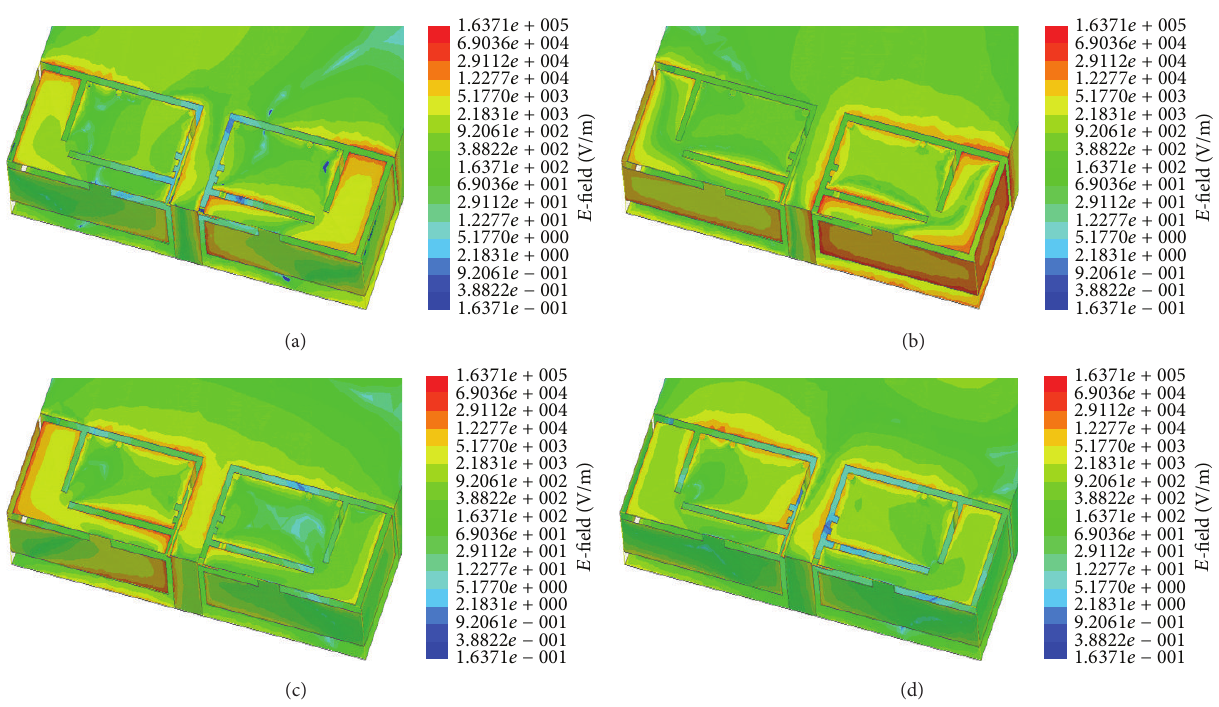
Figure 6: Simulated magnitude of E-field distribution: (a) 0.92 GHz, (b) 1.8GHz, (c) 2.1 GHz, and (d) 2.6